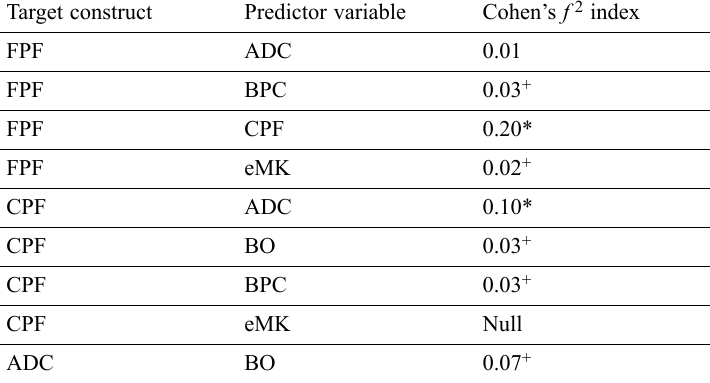
Table 5. Effect size (Cohen’s f 2 index) of predictor variables in the model Target construct Predictor